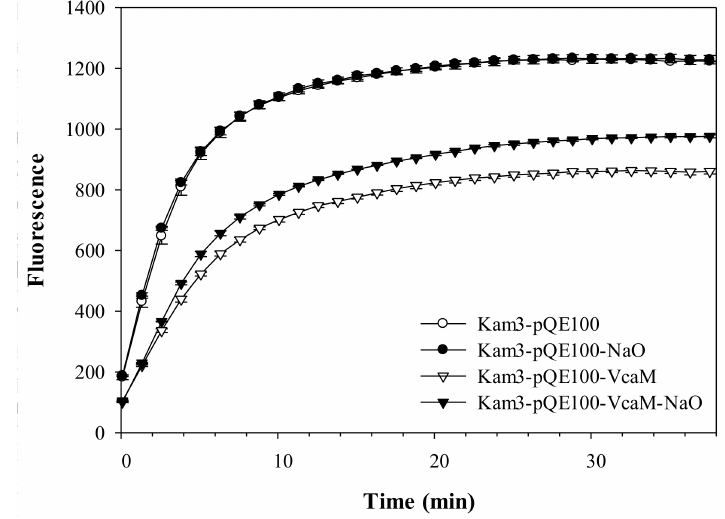
Figure 3. Drug accumulation of H33342 in E. coli Kam3 overexpressing VcaM in the presence of ABC transporter inhibitor NaOV. H33342 was incubated for 38 min in the presence of 40 µ g/mL